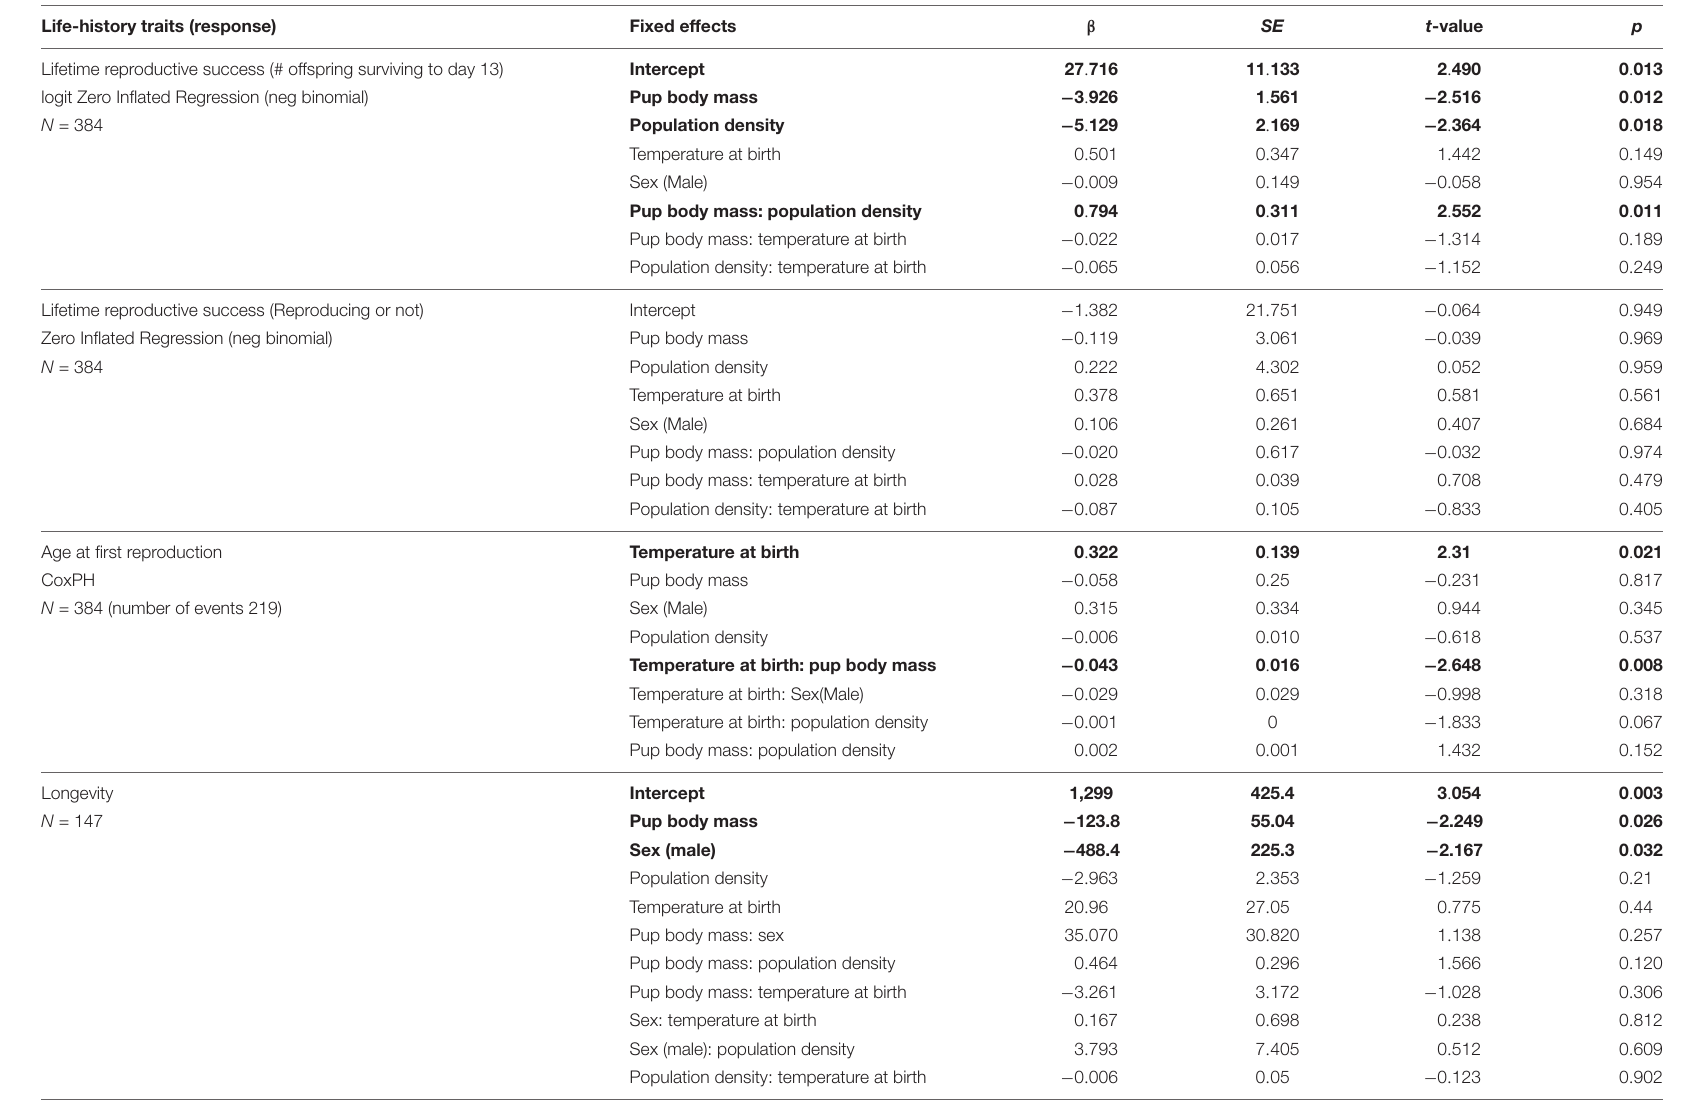
TABLE 1 | Influence of pup body mass at day 13, sex, population density (number of individuals) and temperature at birth and their interactions on individuals’ life-history traits (measured by the age at first reproduction), lifetime reproductive success (analyzing total number of offspring surviving to day 13), the probability to reproduce at all, using the binomial and logit part of zero-inflated regression model and longevity. Life-history traits (response) Fixed